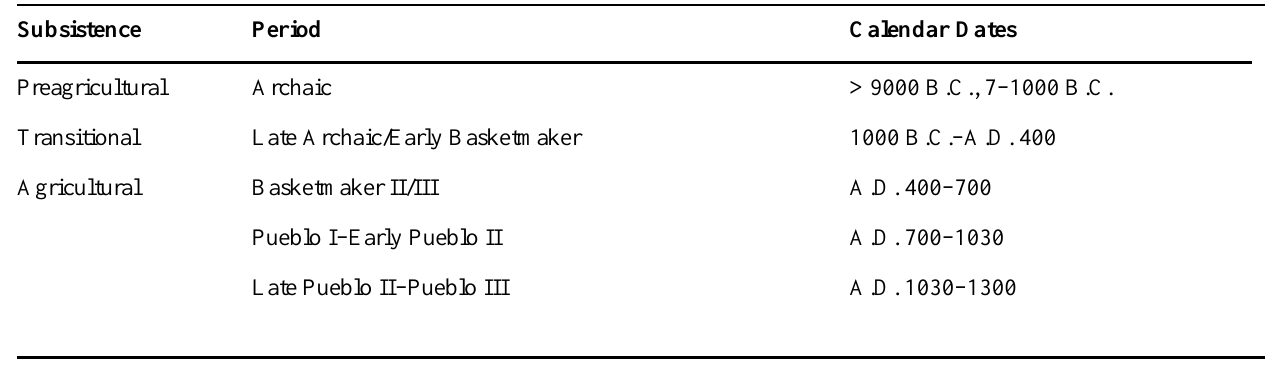
Table 1. Chronology of the Middle Chevelon Creek study